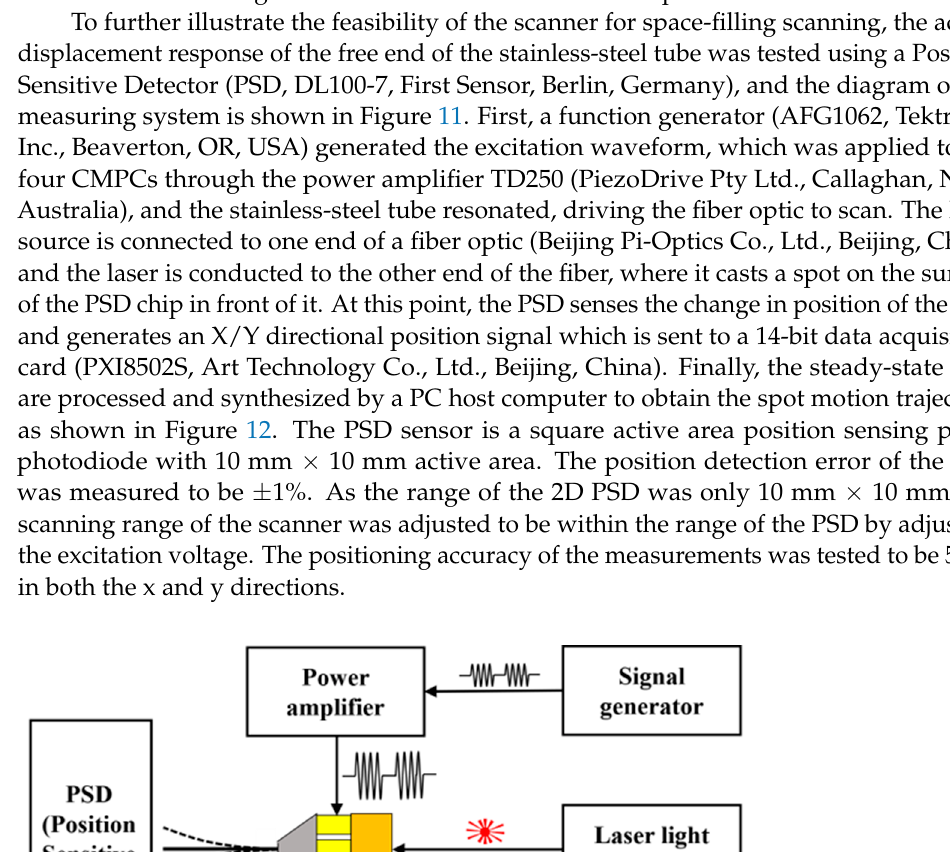
Figure 10. Photos of four types of simple scans. ( a ) Linear scanning in X direction. ( b ) Linear scan- ning in Y direction. ( c ) Circular scanning. ( d ) Elliptical scanning.